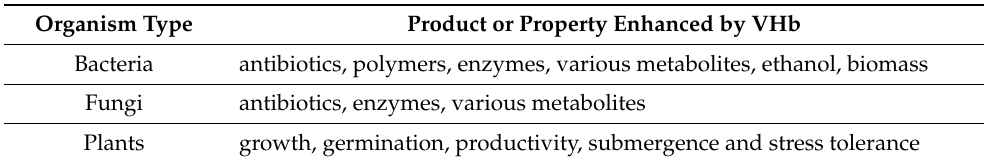
Table 2. Enhancement of valuable products or growth in heterologous organisms expressing VHb. Further information can be found in references [35,36].